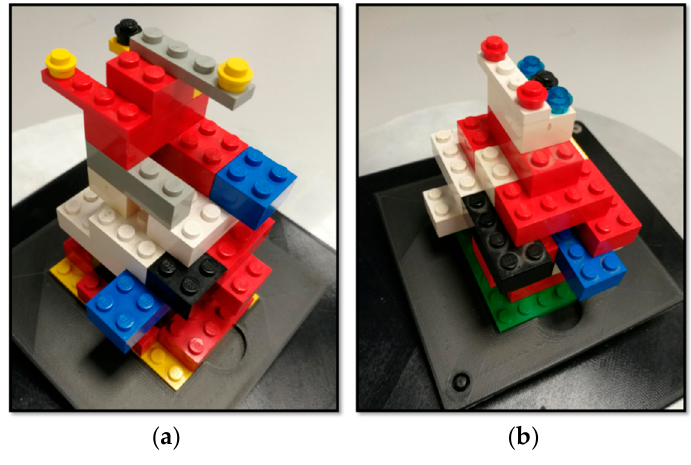
Figure 8. ( a ) Product P1; ( b ) product P2.